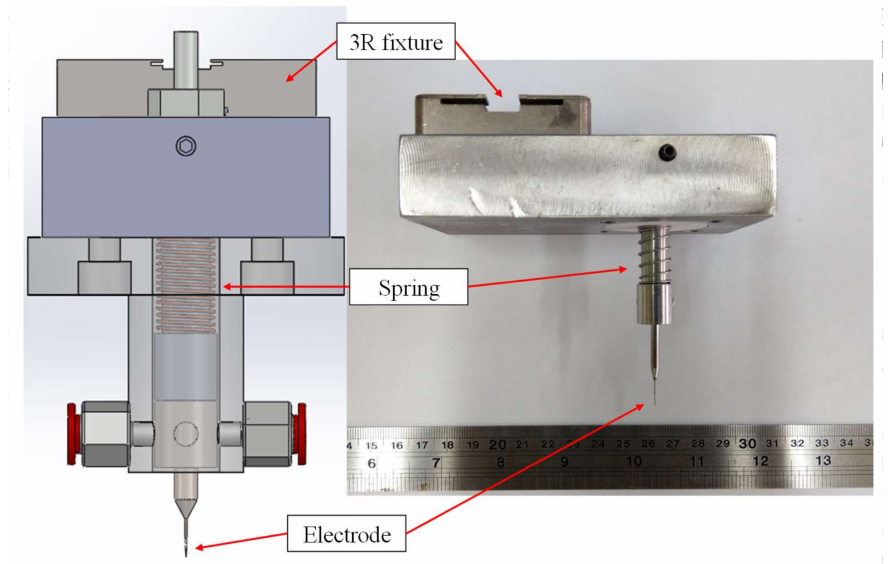
Figure 3. The tapered tool electrodes with a spring-fed